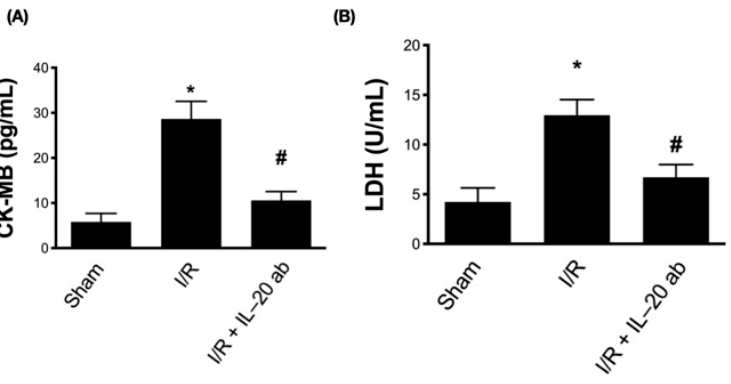
Figure 7. The effect of interleukin (IL)-20 antibody on the concentration of biomarkers for cardiac damage. The concentrations of creatine kinase-MB (CK-MB) ( A ) and lactate dehydrogenase (LDH) ( B ) were checked to determine the extent of myocardial infarction after ischemia/reperfusion (I/R) and the protective effect of IL-20 antibody treatment. The data were presented as the mean ± standard deviation of six animals in each group (* indicating p < 0.05 compared to the sham group; # indicating p < 0.05 compared to the I/R group).